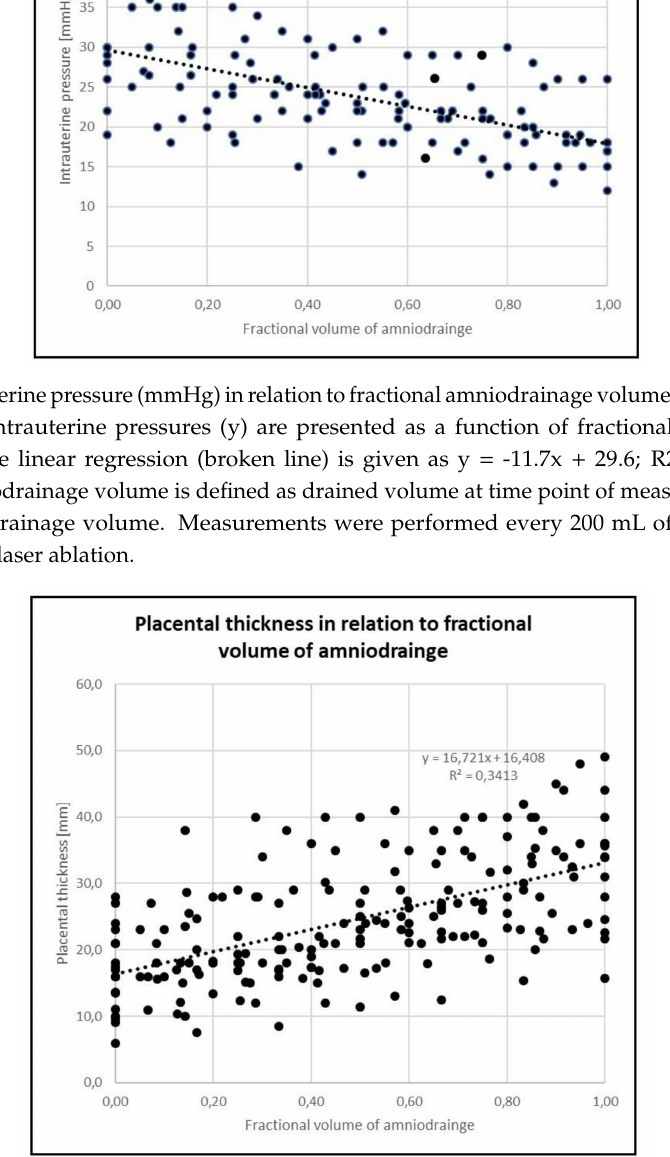
Figure 2. Placental thickness (mm) in relation to fractional amniodrainage volume (0 to 1) following FLA. Data on placental thickness (y) are presented as a function of fractional amniodrainage volume (x). The linear regression (broken line) is given as y = 16.7x + 16.4; R 2 = 0.34, n = 18. Fractional amniodrainage volume is defined as drained volume at time point of measurement divided by total amniodrainage volume. Measurements were performed every 200 mL of amniodrainage. FLA: fetoscopic laser